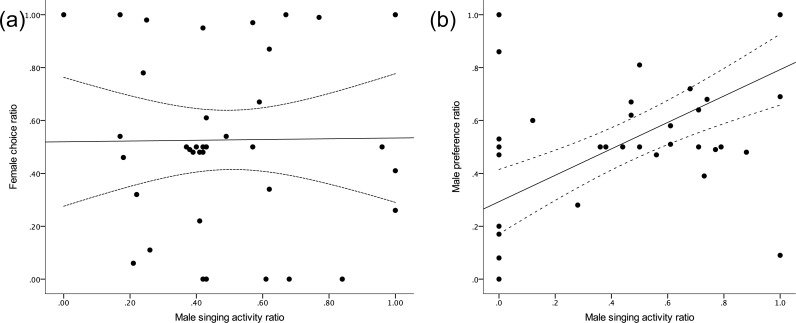
(A) Female preference for males of the higher quality nutritional treatment, respectively, did not correlate with singing proportion of the males in the female choice tests (B). In the male choice tests, i.e., when males could actively choose a female, males sang more in front of their preferred female. Regression lines with confidence intervals (hatched lines) to visualize relations.